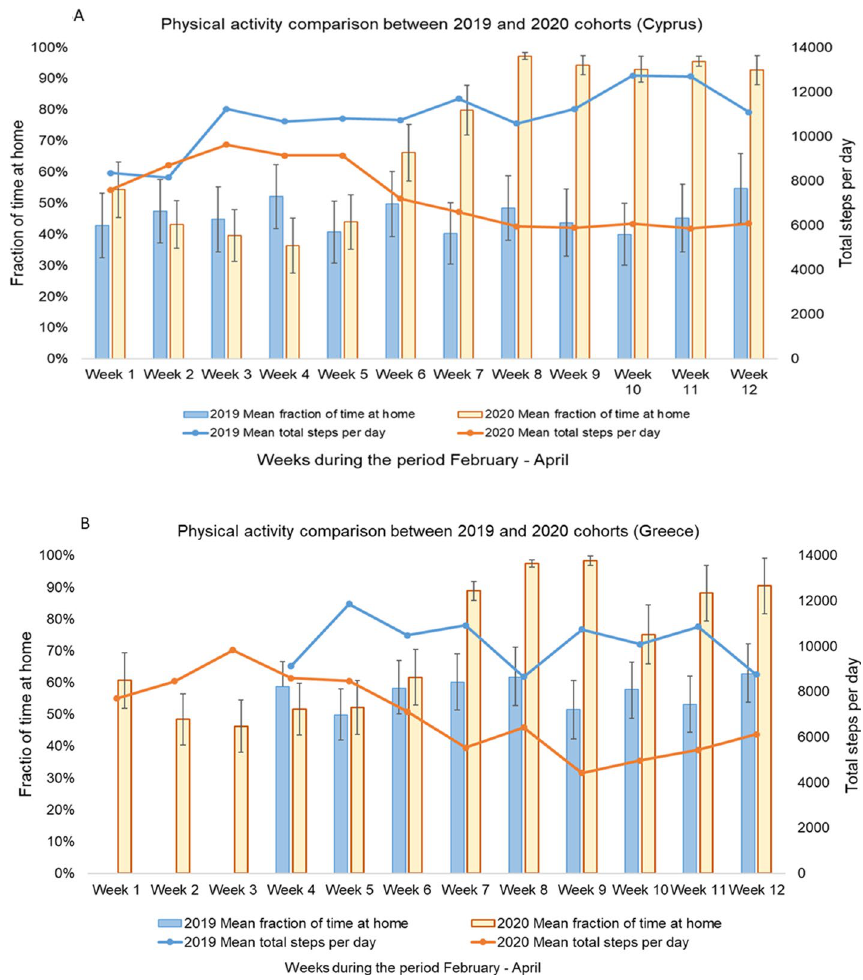
Figure 2. Comparison of mobility of asthmatic children recorded in February–April 2019 and February–April 2020 in Cyprus and Crete. Weekly averages of fraction time spent at home and steps/day during the same period of 2019 and 2020 in Cyprus ( A ) and Greece ( B )